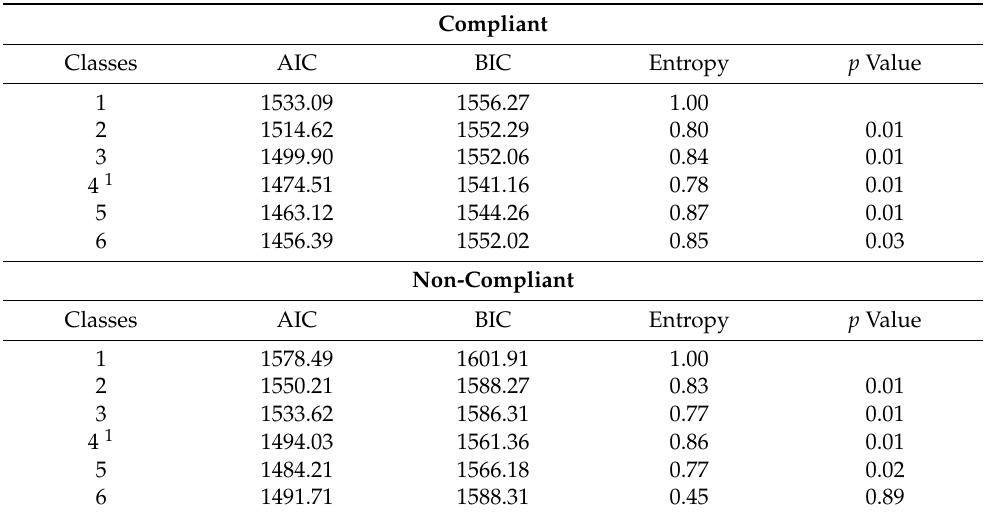
Table 2. Criteria to model fit of latent profile